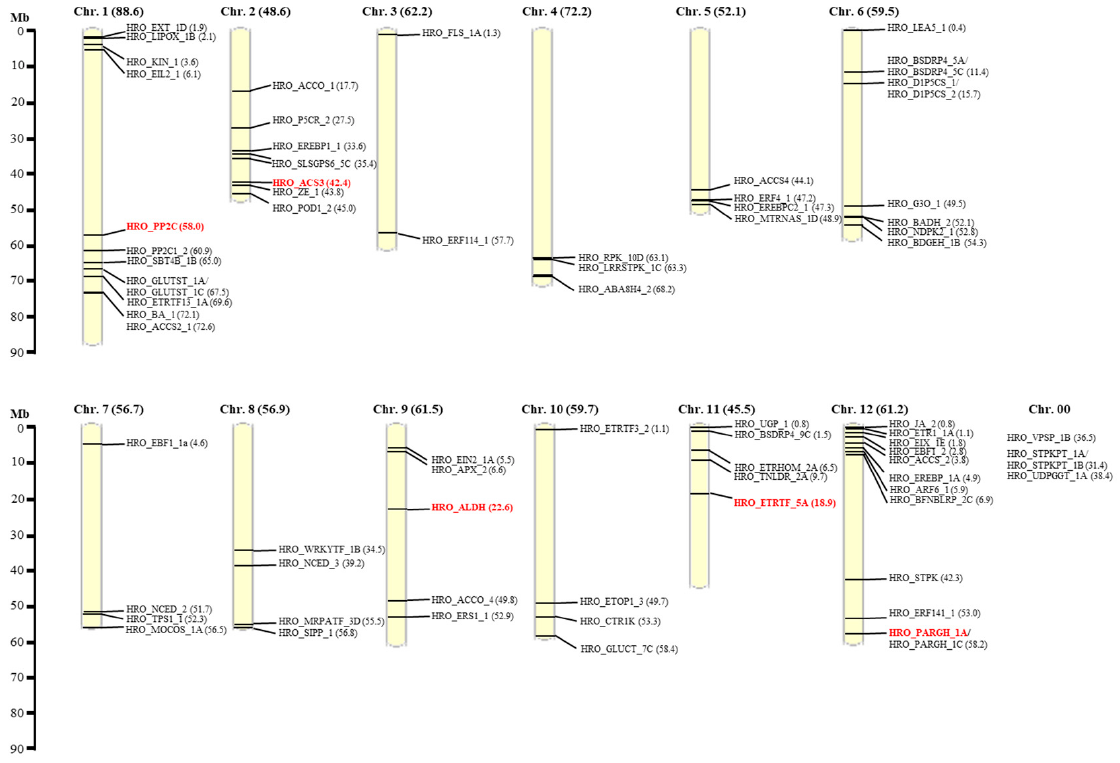
Figure 3. Physical location of the candidate gene specific SSR markers according to the potato reference genome (The Potato Genome Consortium 2011).